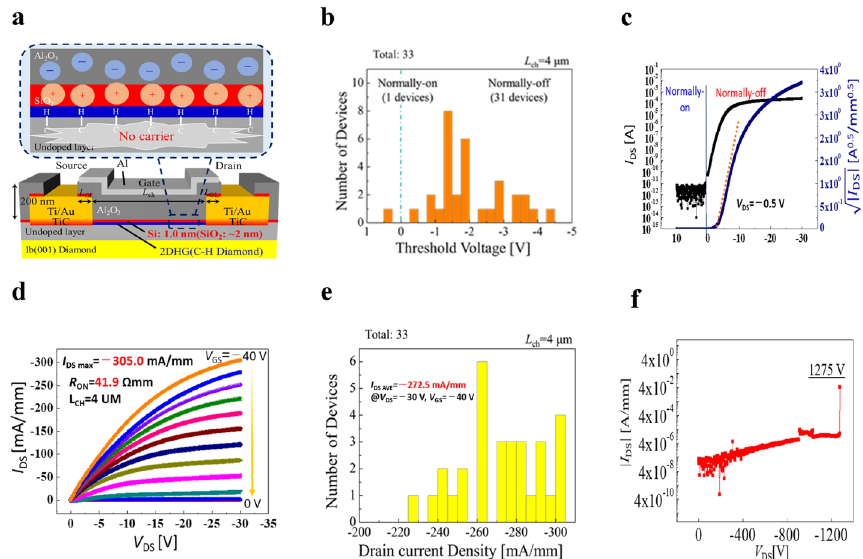
Figure 1. The I DS – V DS characteristics of 2DHG Al 2 O 3 /SiO 2 /diamond MOSFET after confirming the SiO 2 close to the surface, experimentally. (a) Cross-sectional representation of the 2DHG diamond MOSFET (blue line) with the SiO 2 layer (red line) placed close to the interface. (b) V th distribution of actual MOSFETs device with SiO 2 of the 33 samples. The V th ’s are within the range from 0.5 V to − 4.5 V, and almost all devices operate in the enhancement mode (normally-off). (c) I DS − V GS characteristic of SiO 2 /diamond MOSFET device, where the V th = − 3.5 V at V DS = − 0.5 V. (d) The diagram of I DS − V DS characteristics of SiO 2 /diamond MOSFET showed the maximum drain current obtained at I DS MAX = − 305.0 mA/mm when drain voltage was fixed at − 30 V, V GS was varied from − 40 V to 0 V with a voltage step of 4 V. (e) Drain current density distribution of actual MOSFET devices of 33 samples in which all devices achieved high drain current density (>220 mA/mm). (f) The breakdown voltage achieved at 1275 V with the gate drain distance L GD = 20